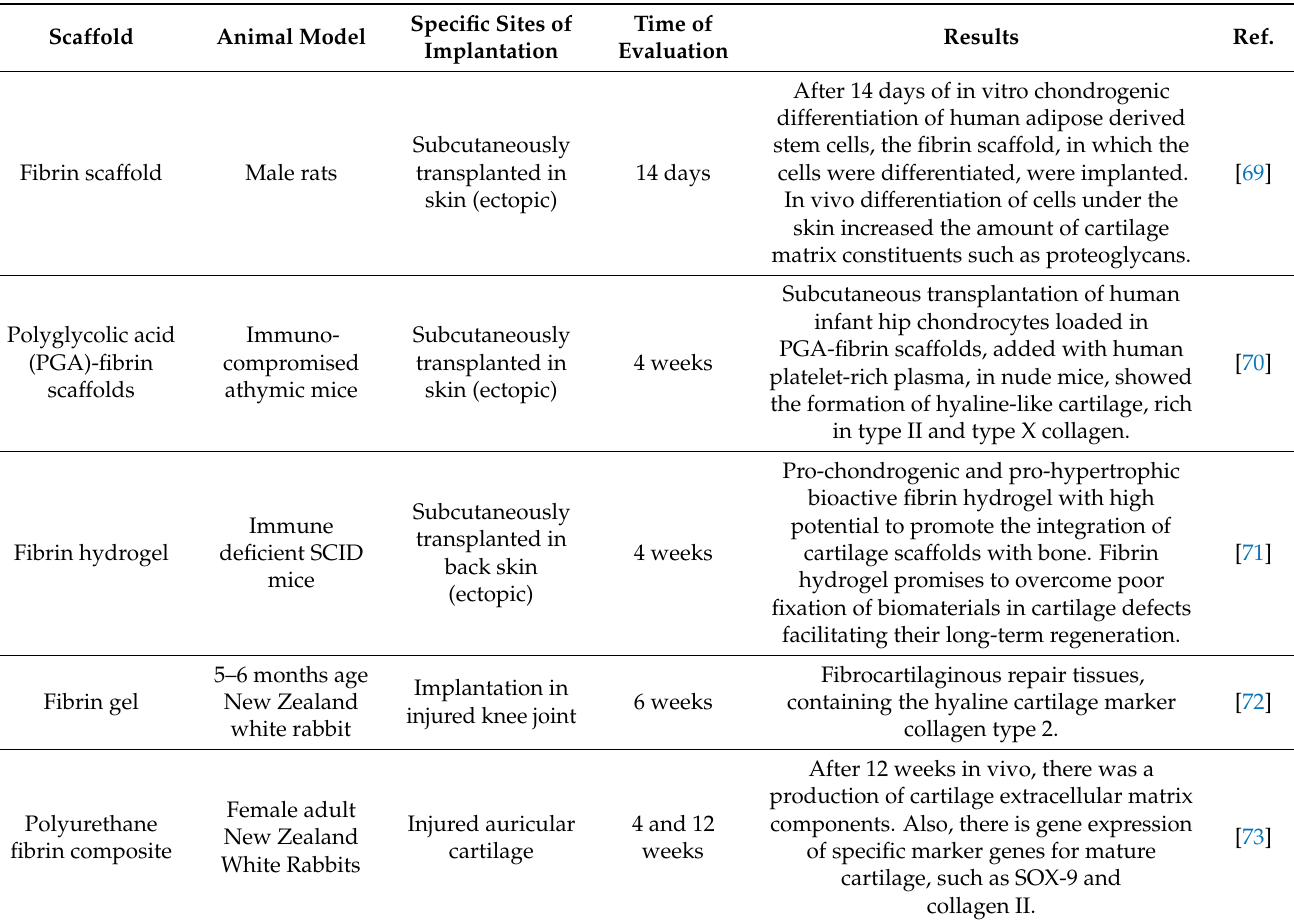
Table 3. Examples of fibrin scaffolds or fibrin mixed with other biomaterial for in vivo applications.